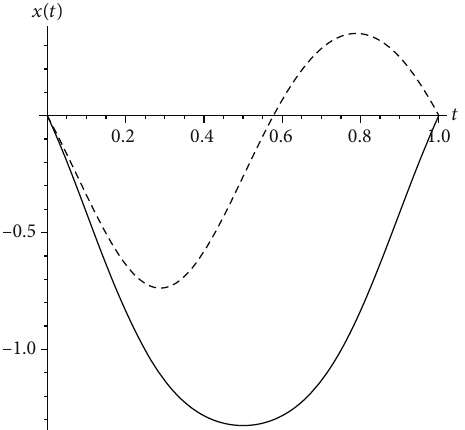
Figure 10: Graphs x ð t Þ for solutions of problems (30) and (31), α ≈ − 3 : 11 , α ≈ − 3 : 6605